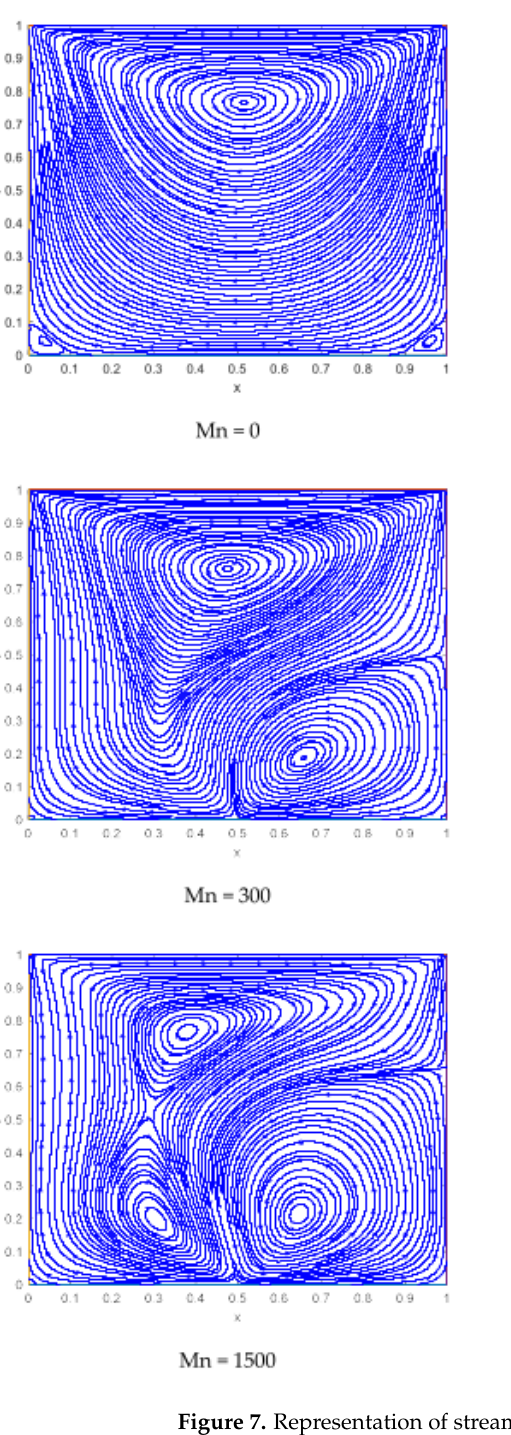
Figure 7. Representation of streamlines for various values of magnetic interaction